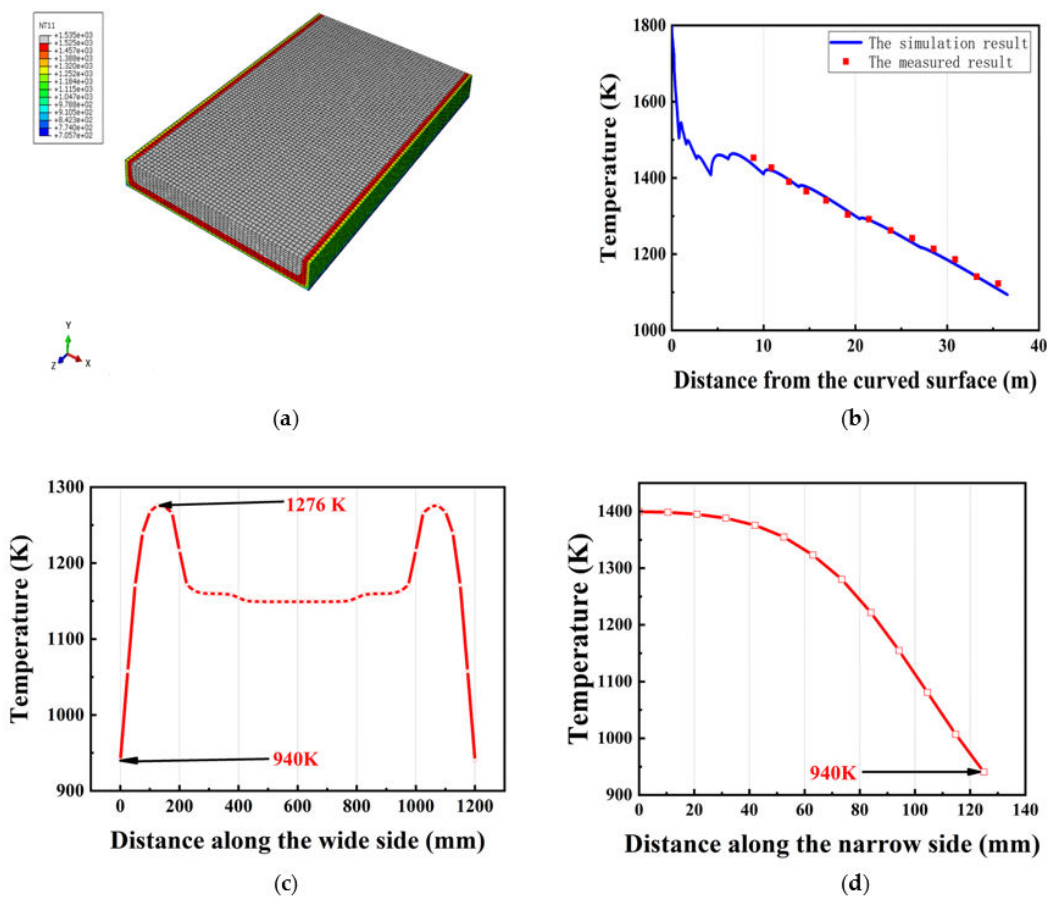
Figure 3. ( a ) Temperature field of the model. ( b ) The comparison of the measured and simulated temperature in the center of the narrow face. ( c ) Temperature on the wide side. ( d ) Temperature on the narrow